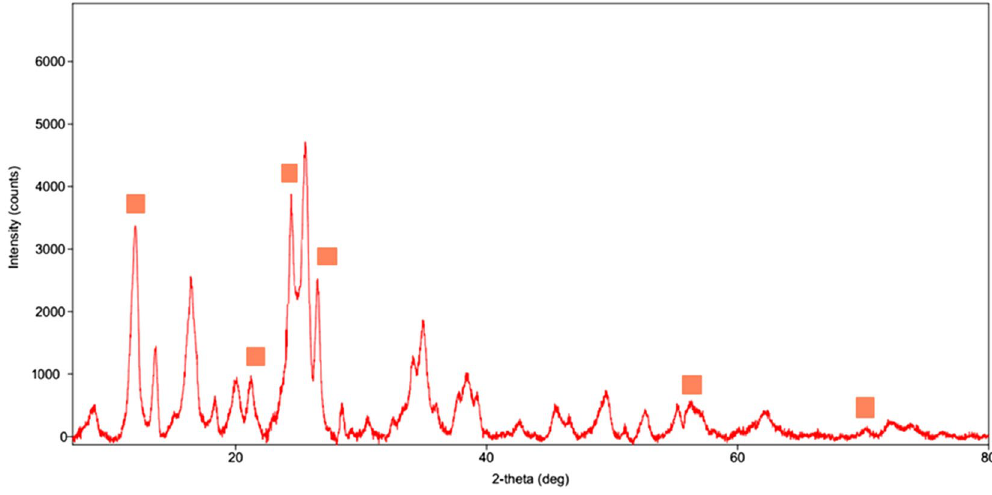
Figure 6. The XRD curve of